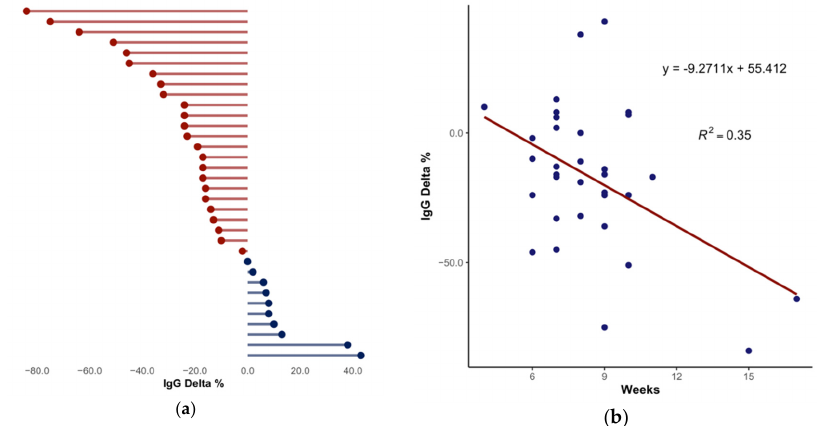
Figure 5. Longitudinal study. ( a ) IgG level variation in 33 asymptomatic subjects. ( b ) Negative correlation between IgG Delta % and elapsed weeks (one-way ANOVA, p = 0.0003). In total, 67% of subjects ( n = 22) showed a decrease in IgG